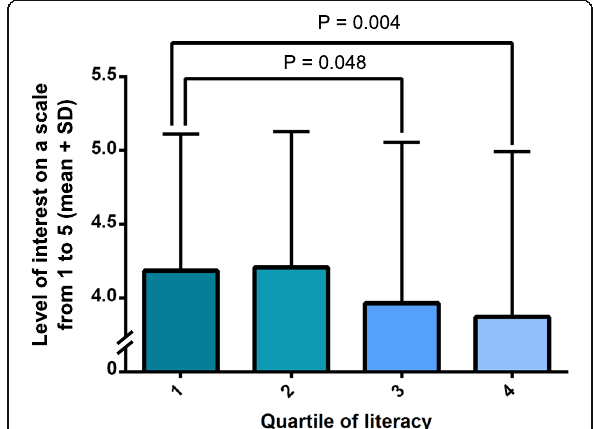
Fig. 1 Level of interest in nutrigenetic testing according to quartiles of genetic literacy. SD is standard